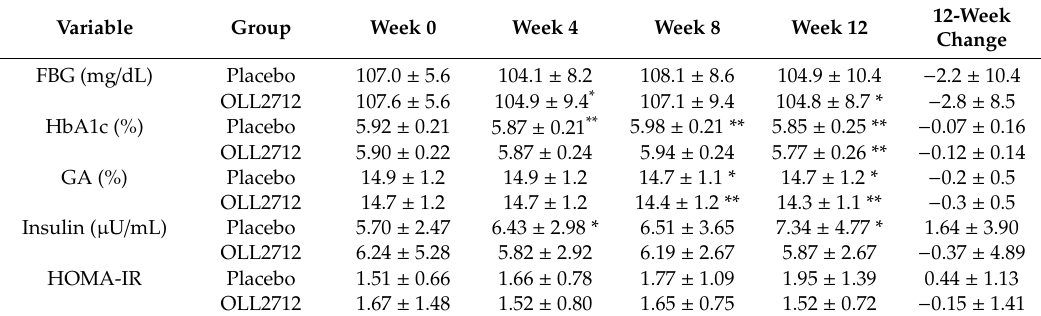
Table 5. Subgroup analysis in the participants who met the selection criteria at week 0